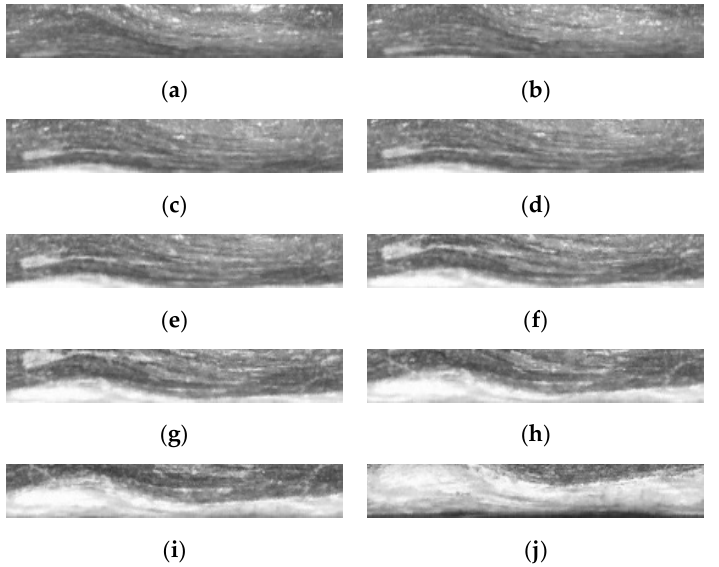
Figure 9. Selected 10 frame unfolded images from ( a – j ) for frames 1, 21, 43, 65, 85, 106, 127, 148, 169 and 210, respectively.